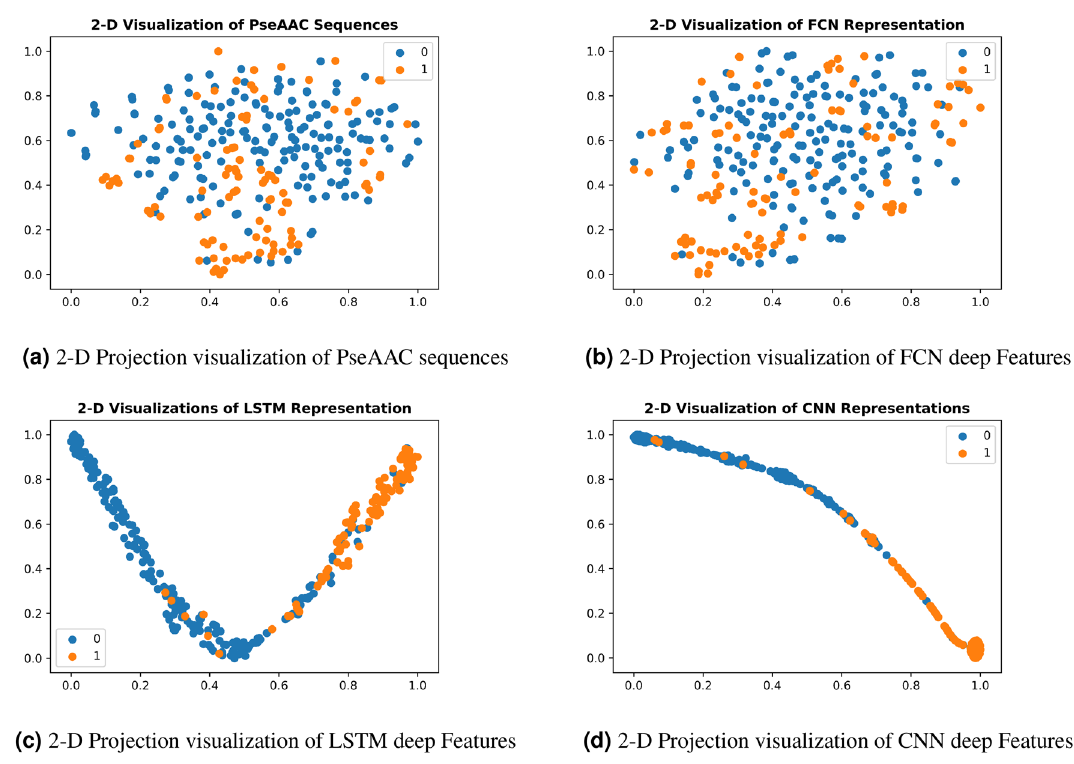
Figure 6. Feature space visualizations of deep representations for positive and negative CarboxE